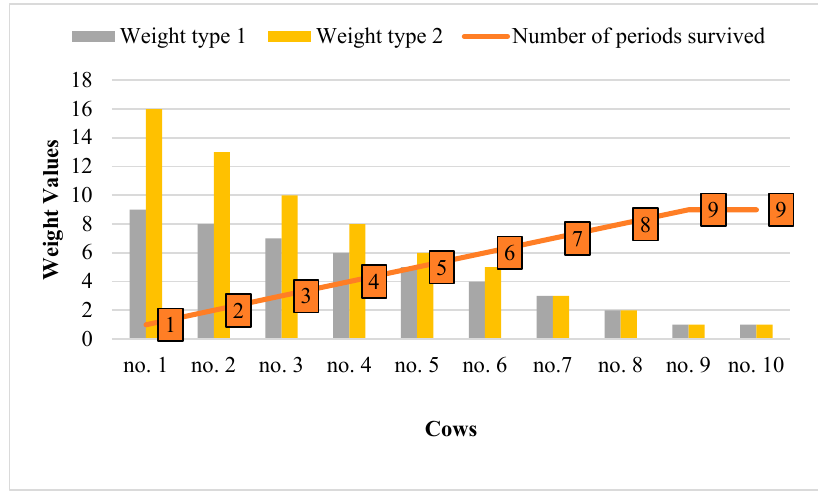
Figure 1. Weight values by the number of periods survived. Table 1. Weights, breeding value, and reliability of breeding value for 10 di ff erent individuals.